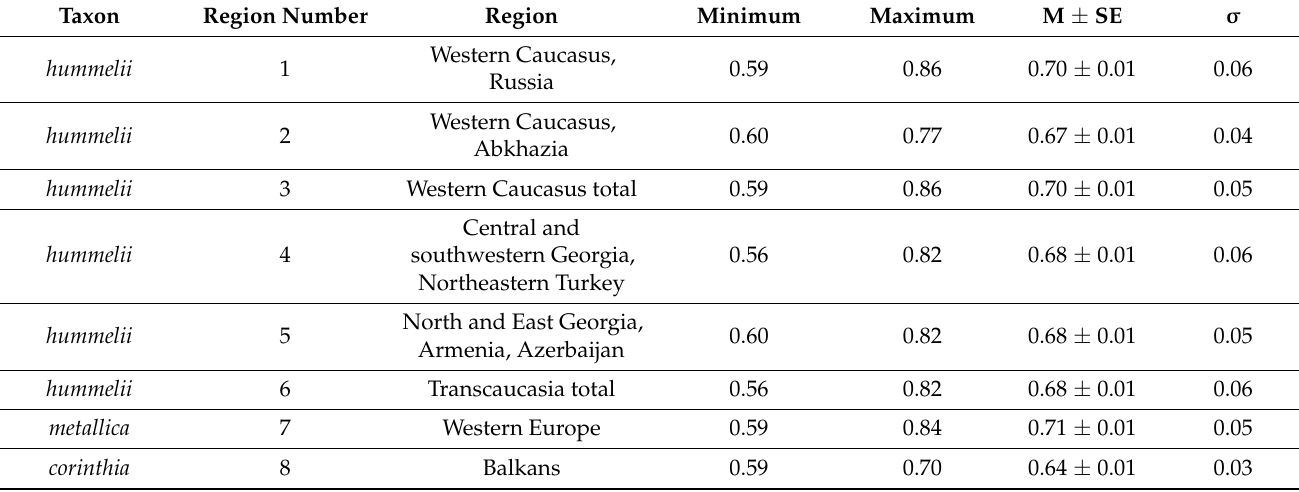
Table 5. Size of the pronotum (b): pronotal width (in dorsal view)/elytral length. M—mean value, σ —standard deviations, SE—standard